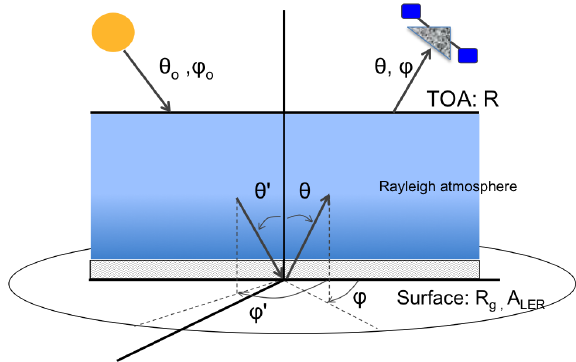
Figure 3. Sketch of the surface to top-of-atmosphere system with zenith and azimuth angles that define incident ( θ (cid:48) , ϕ (cid:48) ) and reflected ( θ , ϕ ) directions of light. Direct incident solar light is described by ( θ 0 , ϕ 0 ). A LER is the Lambertian surface albedo and R g the surface